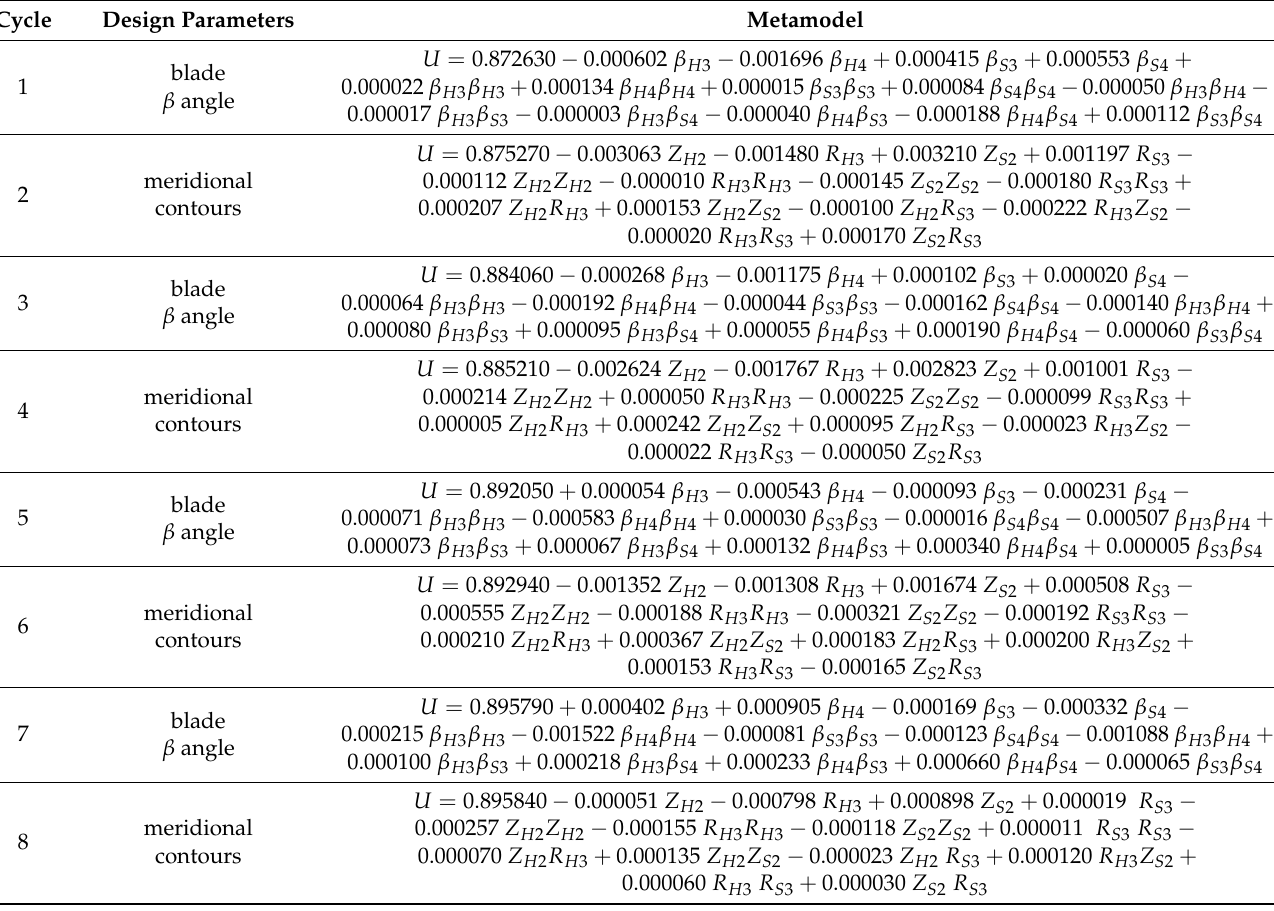
Table 5. Design parameters and metamodel in each optimization cycle.